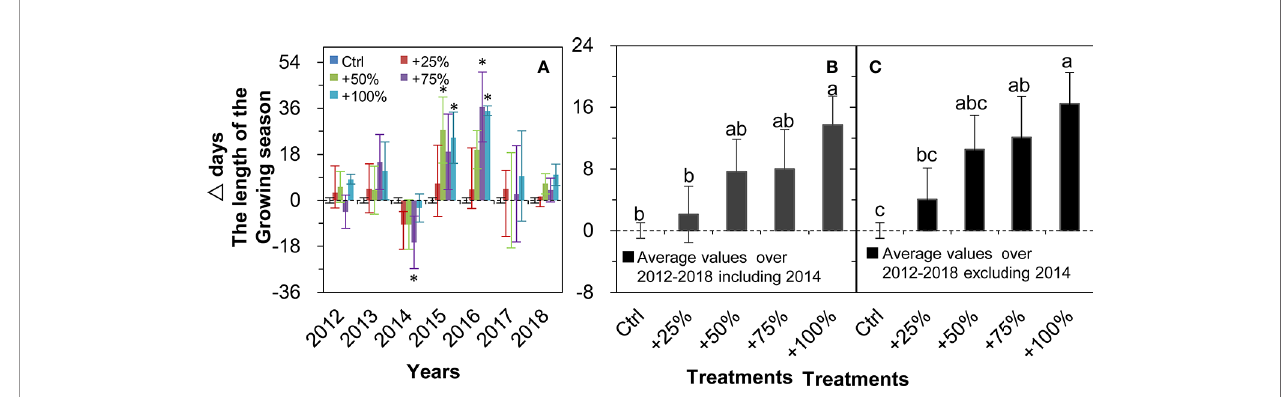
FIGURE 6 | Relative changes ( △ days; mean ± SE) in the growing season length of N. tangutorum after water addition treatments (+25% to +100%) compared with the control (Ctrl). Positive and negative values represent prolonged and shortened days, respectively. A – C represent the length of the growing season. * indicates signi fi cant differences at the P < 0.05 level compared with values in